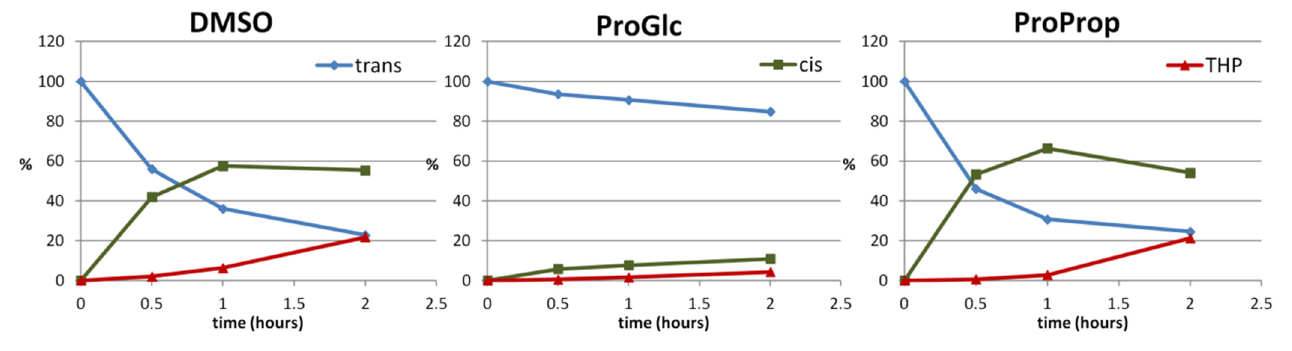
Figure 8. Kinetics of the photochemical reactions of trans -resveratrol UV-light irradiation in different solvents.